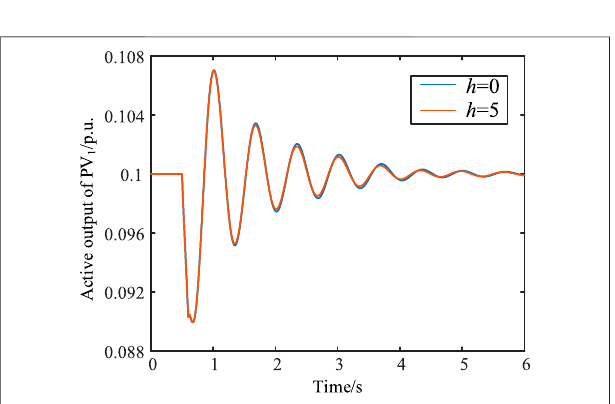
FIGURE 17 | Non-linear simulation results of the active power output of PV 1 in the new